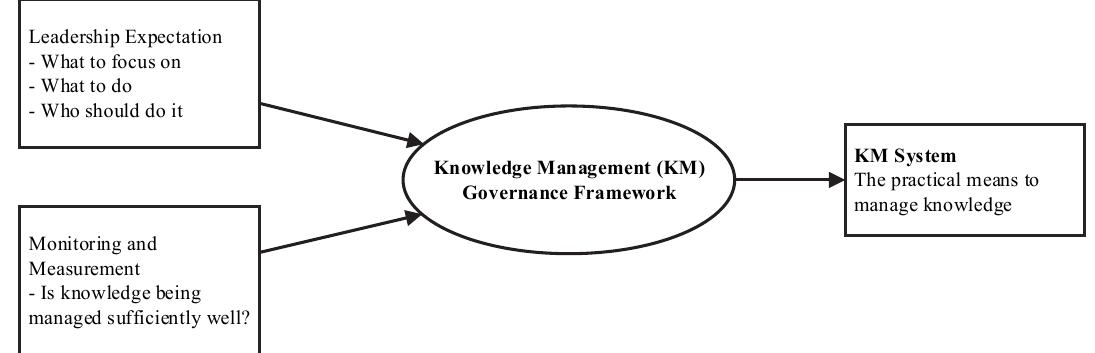
Fig. 1 . Knowledge Management (KM) Governance Framework